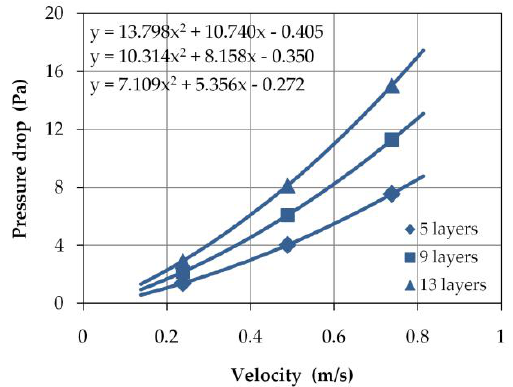
Figure 9. Examples of hydraulic characteristics of a fixed-bed with 3-mm spheres filling.